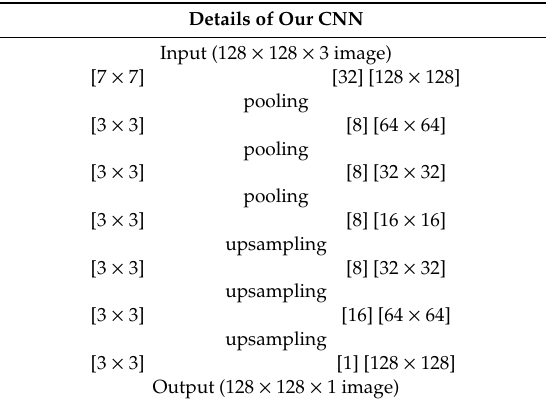
Table 2. Summary of the CNN configuration. First column indicates the size of the filters while second column details the output of the layer.